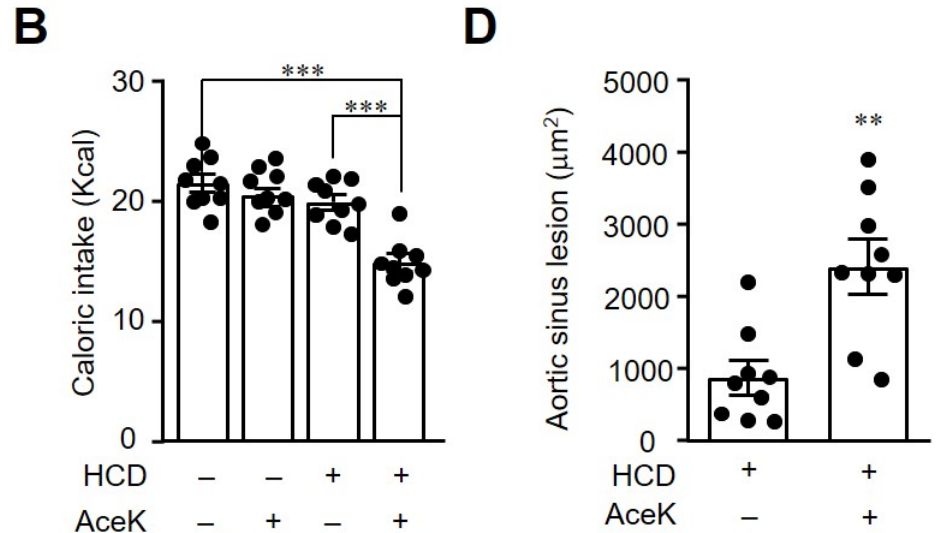
Figure 1. AceK exacerbated atherosclerosis in high cholesterol diet-fed ApoE − / − mice. Mice were fed with chow diet or high cholesterol diet (HCD) for 8 weeks with or without 15 mg/kg AceK administration once daily. The body weight ( A ), and calorie intake ( B ) were recorded. The aortic sinus sections were stained with Oil Red O to visualize the atherosclerotic formed ( C ), and the quantification of the aortic sinus lesion area by imageJ ( D ). ** p < 0.01, *** p < 0.001.